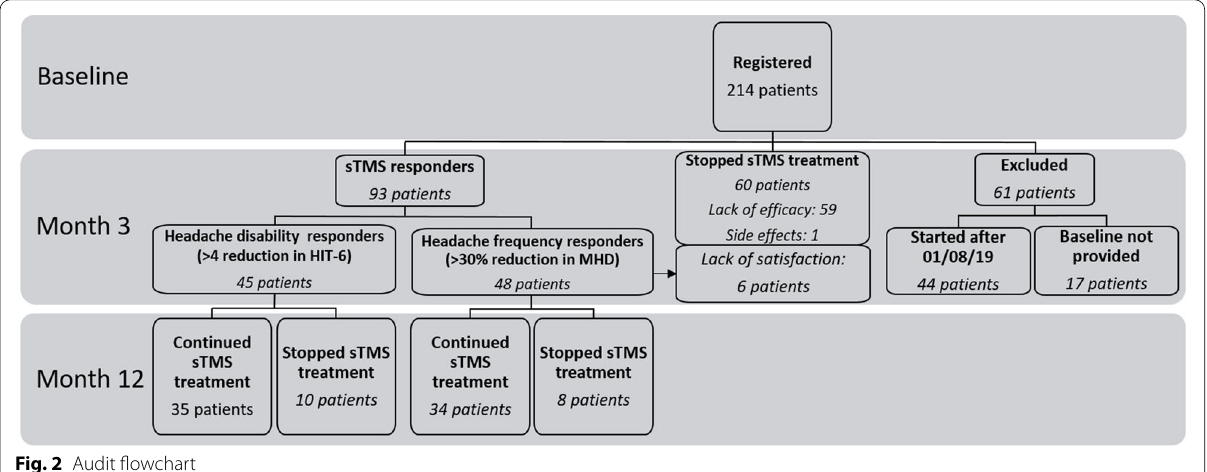
153) treated with single pulse transcranial =